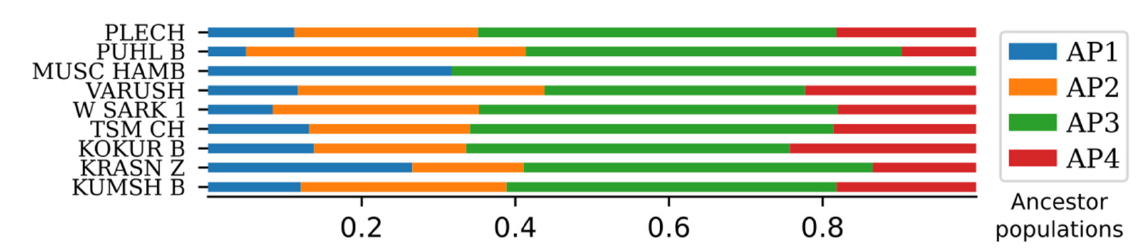
Figure 3. ADMIXTURE analysis (K = 4) for ancestry estimation.